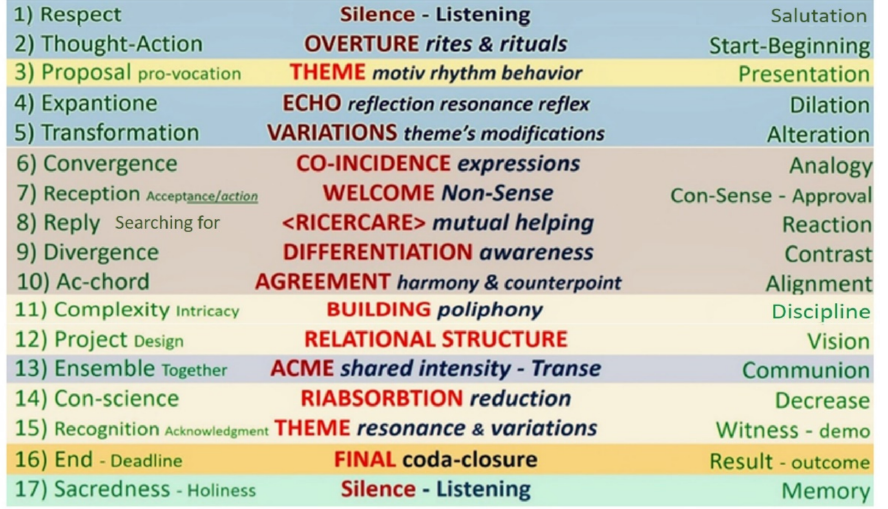
Figure 1. Here located in the middle, the sequence of musical actions which indicates the directions to follow during the overall improvisation. It proceeds vertically, from the first conduct Silence– Listening on top, towards the second one at the bottom. Both sides in parallel, on the right and on the left, show two series of different phases. Step by step, they reflect the same central procedure, however using different terms, essentially coming from diverse points of perception.